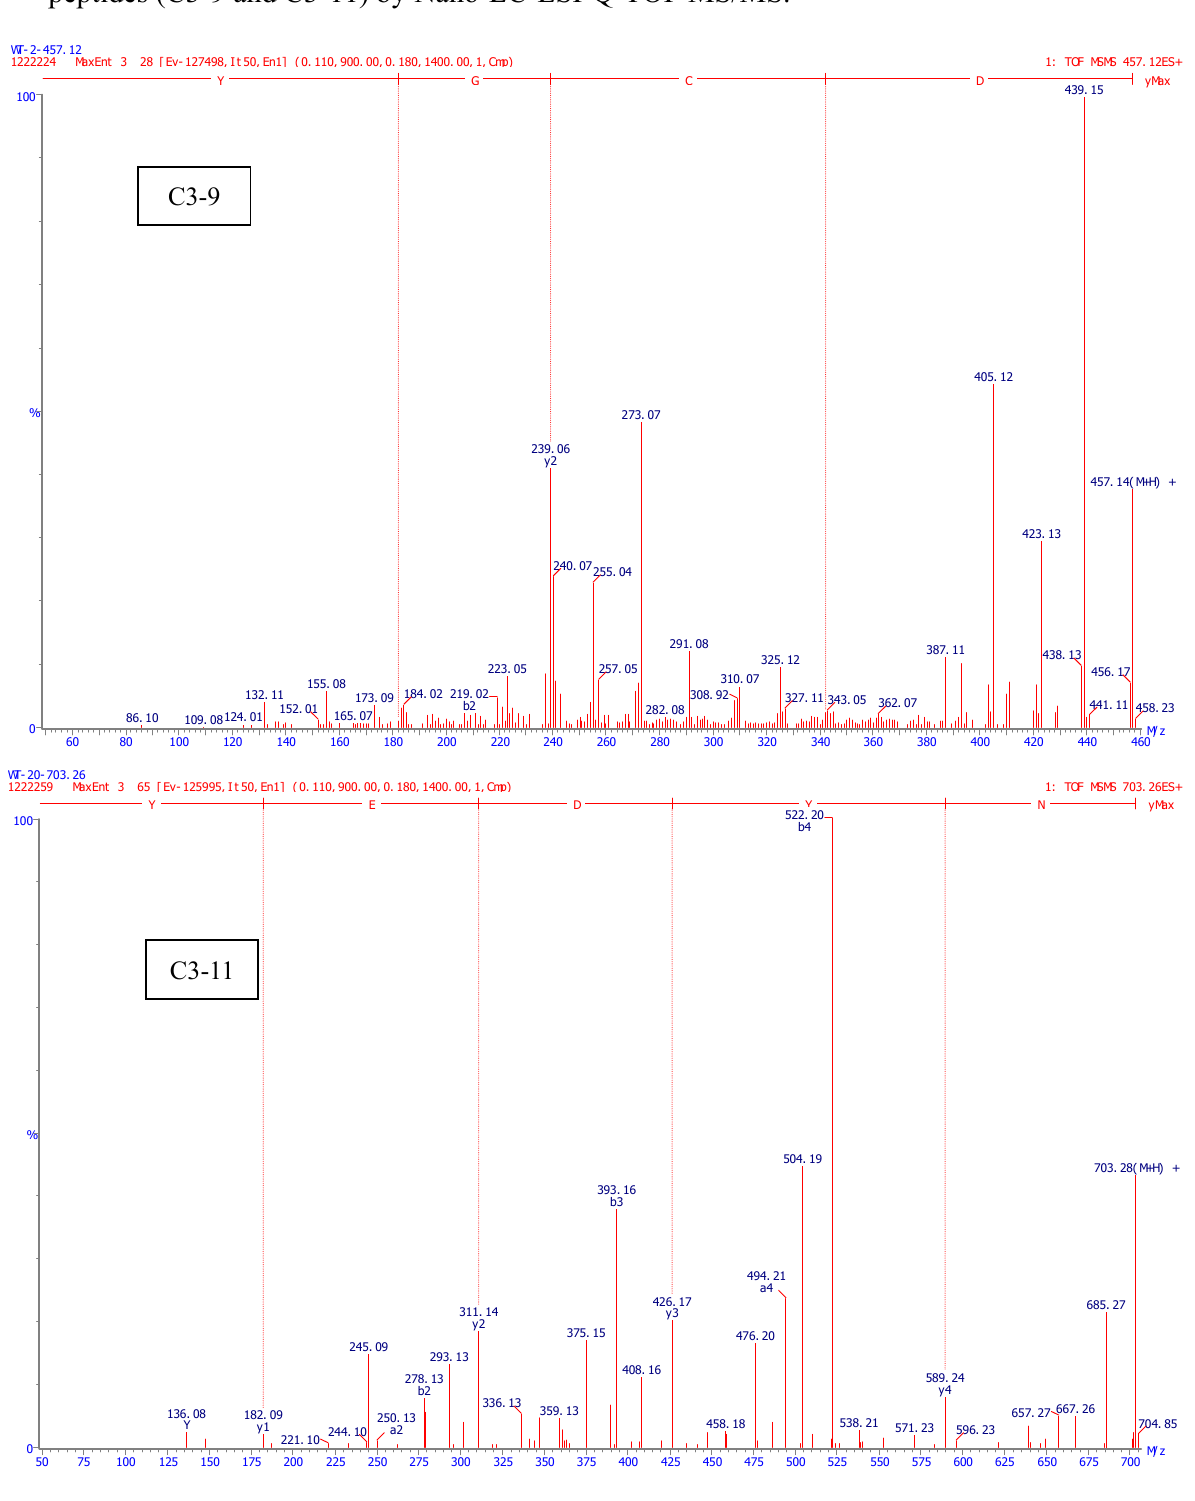
Figure 5. Identification of molecular mass and amino acid sequences of the purified peptides (C3-9 and C3-11) by Nano-LC-ESI-Q-TOF